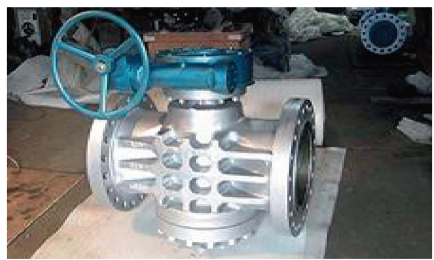
Figure 1: Plug valve with inverted plug type